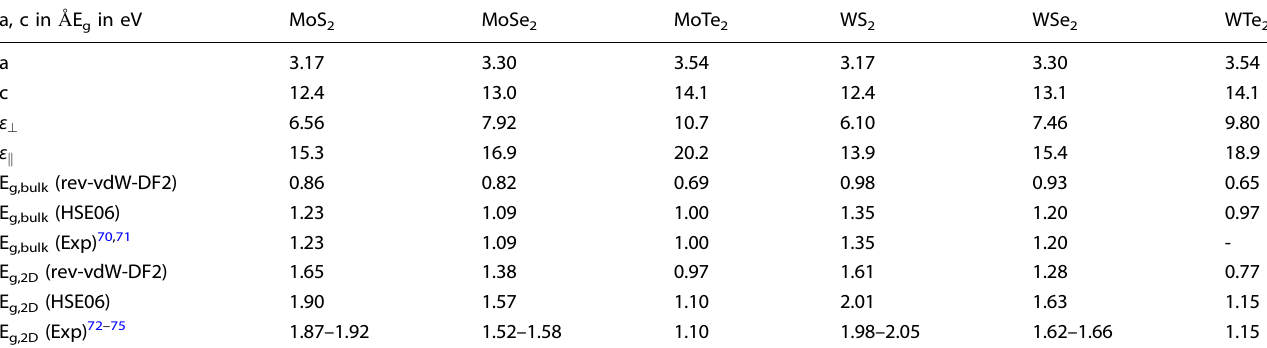
Table 1. Lattice constants, dielectric constants, and band gaps of